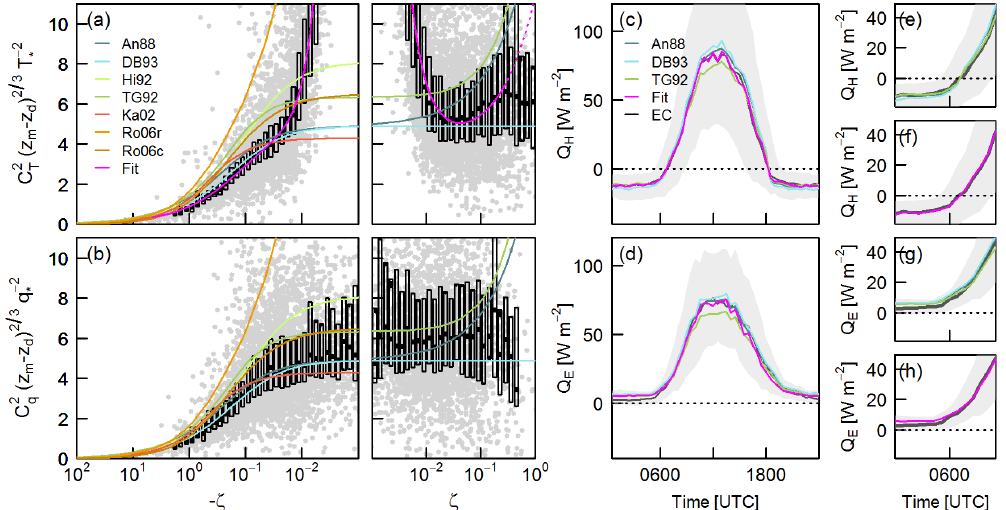
Figure A1. Comparison between EC data and similarity functions from the literature: An88 (Andreas, 1988), DB93 (De Bruin et al., 1993), Hi92 (Hill et al., 1992), TG92 (Thiermann and Grassl, 1992), Ka02 (Kanda et al., 2002) and Ro06 (Roth et al., 2006) fits to rooftop (r) and canyon (c) data sets. Box plots (a, b) indicate median and inter-quartile range (IQR) binned by stability. A fit to the Swindon data ( | Q H | > 5Wm − 2 , | Q E | > 5Wm − 2 ) is also shown for temperature (a) . Median diurnal cycle of (c) Q H and (d) Q E for all available data as measured directly by EC (IQR shaded) and as calculated via structure parameters using the similarity functions indicated. The morning transition is magnified in (e) – (h) ; the fitted function is used in (f, h)